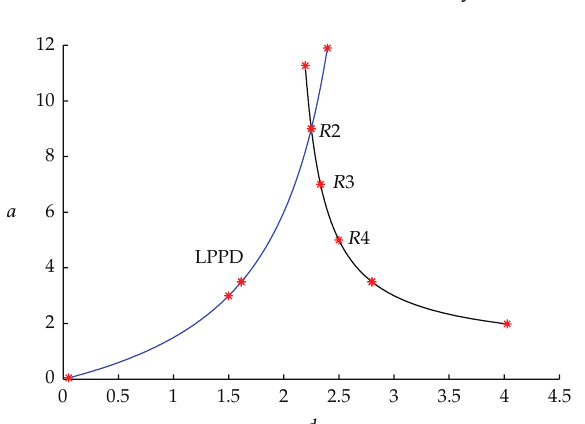
Figure 5: Flip and Neimark-Sacker bifurcation curves starting from points in Run 2 . We note that the LPPD point is in reality a BPPD